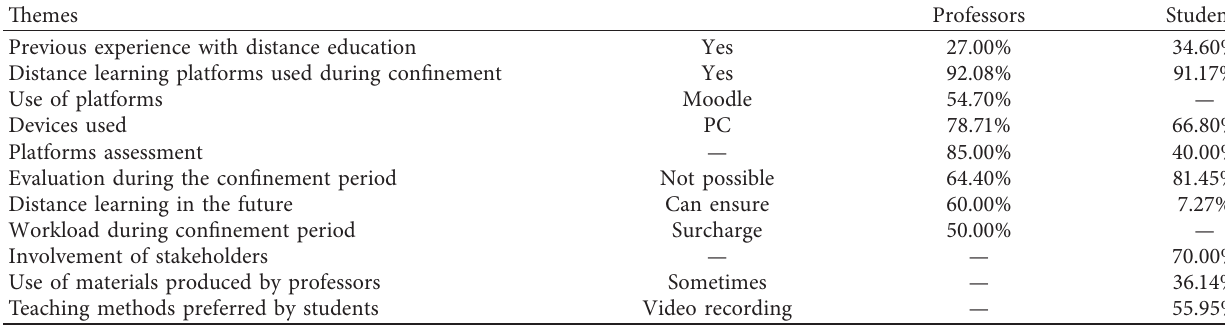
Table 10: The resulting classification for professors and students.